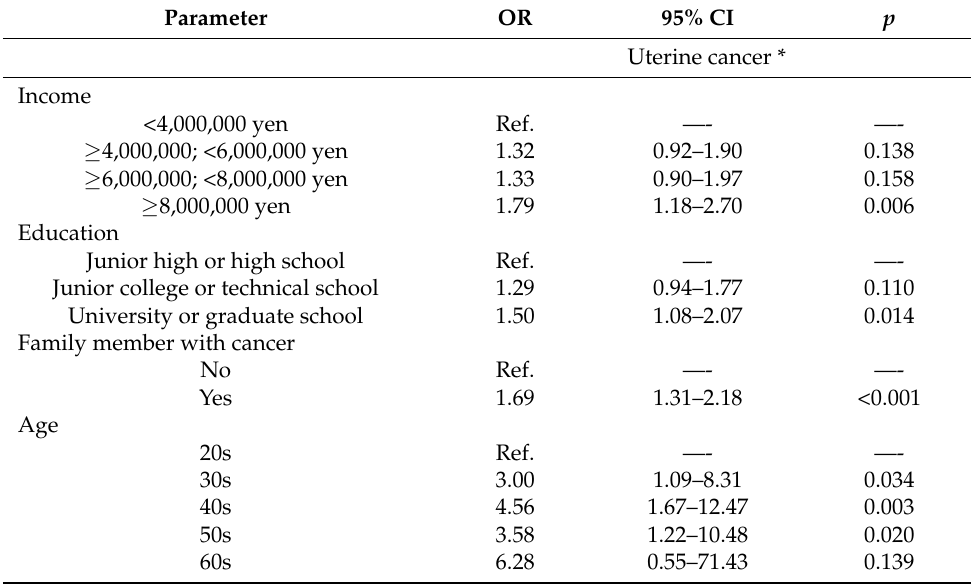
Table 6. Factors associated with the uterine cancer screening experience in